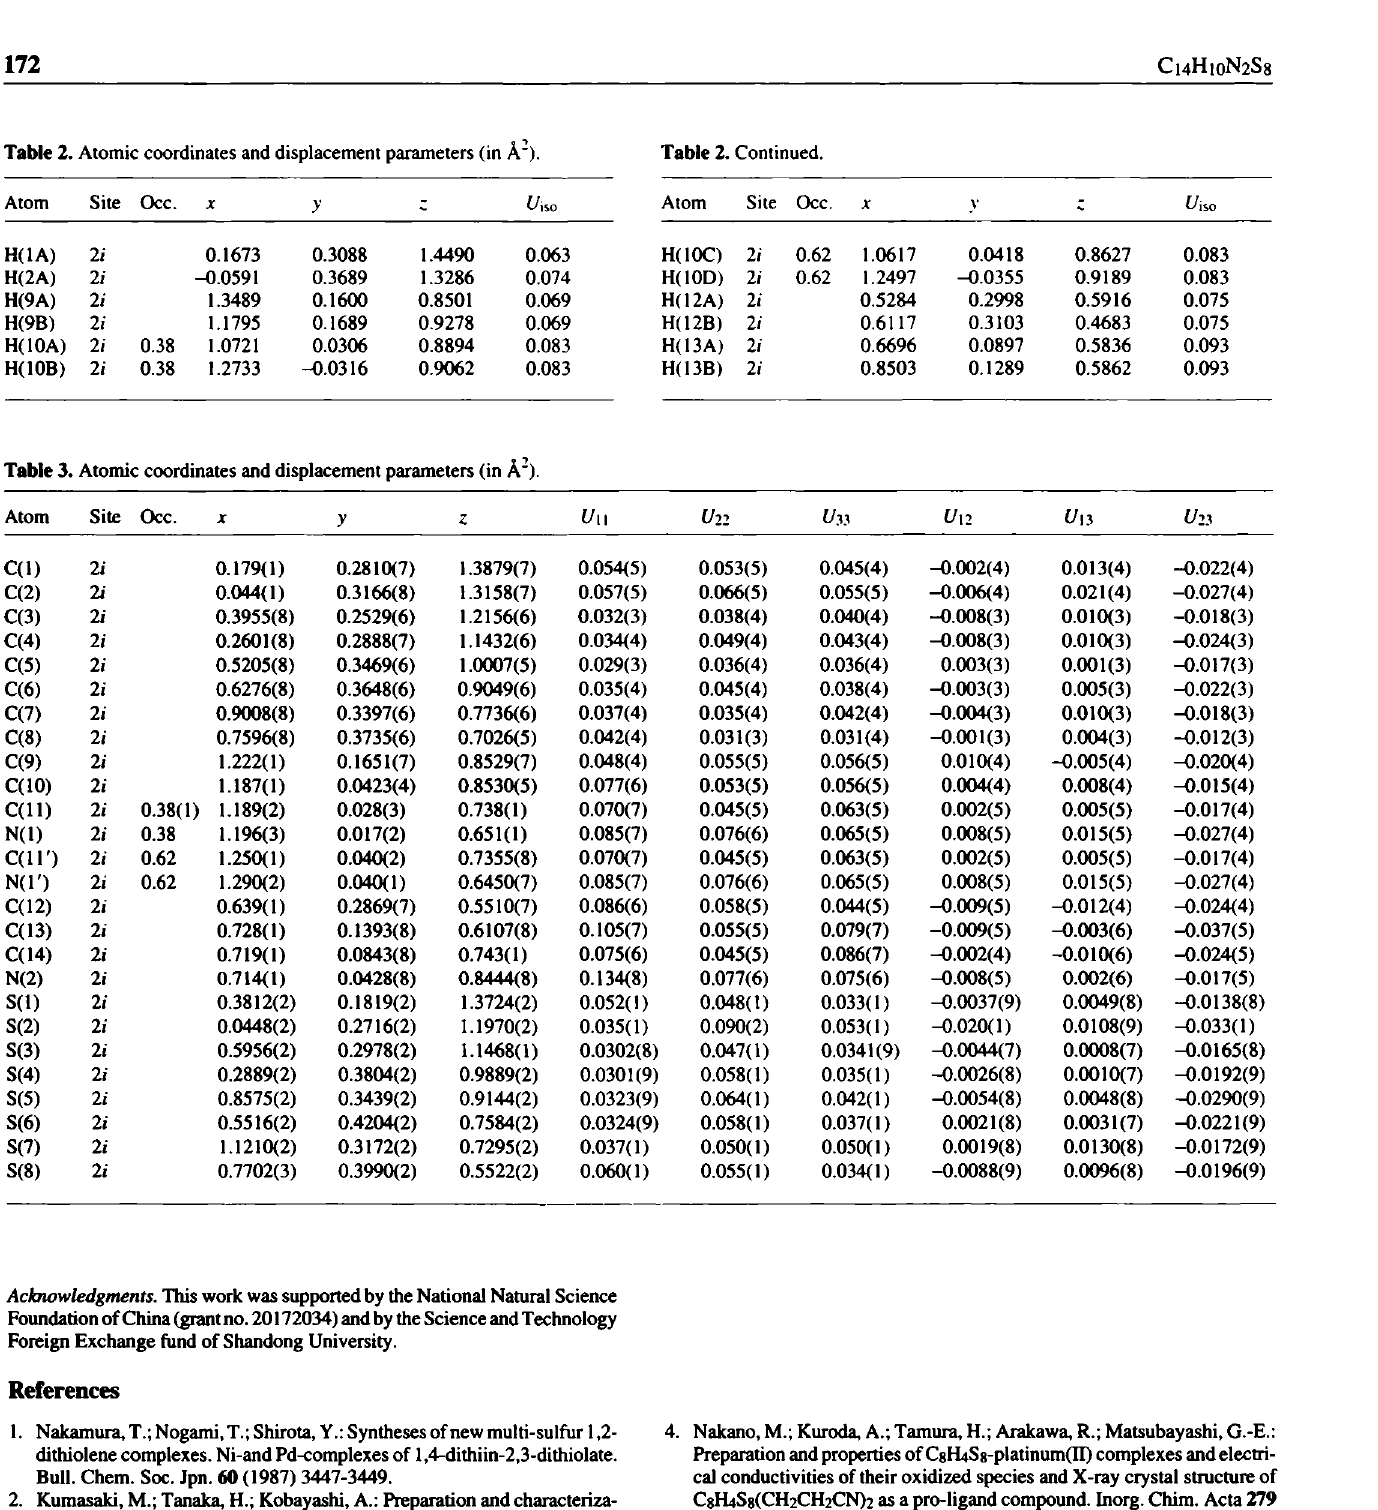
Table 2. Atomic coordinates and displacement parameters (in A : ). Table 2. Continued.